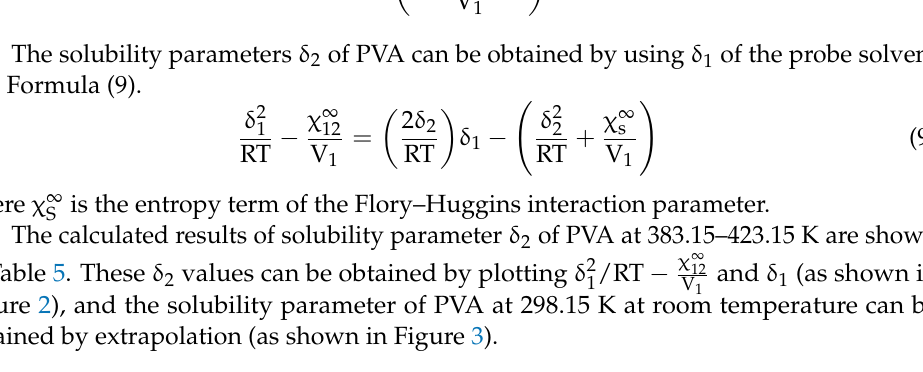
Table 5. Solubility parameters δ 2 of PVA at different temperatures ((J/cm − 3 ) 0.5 ). Model